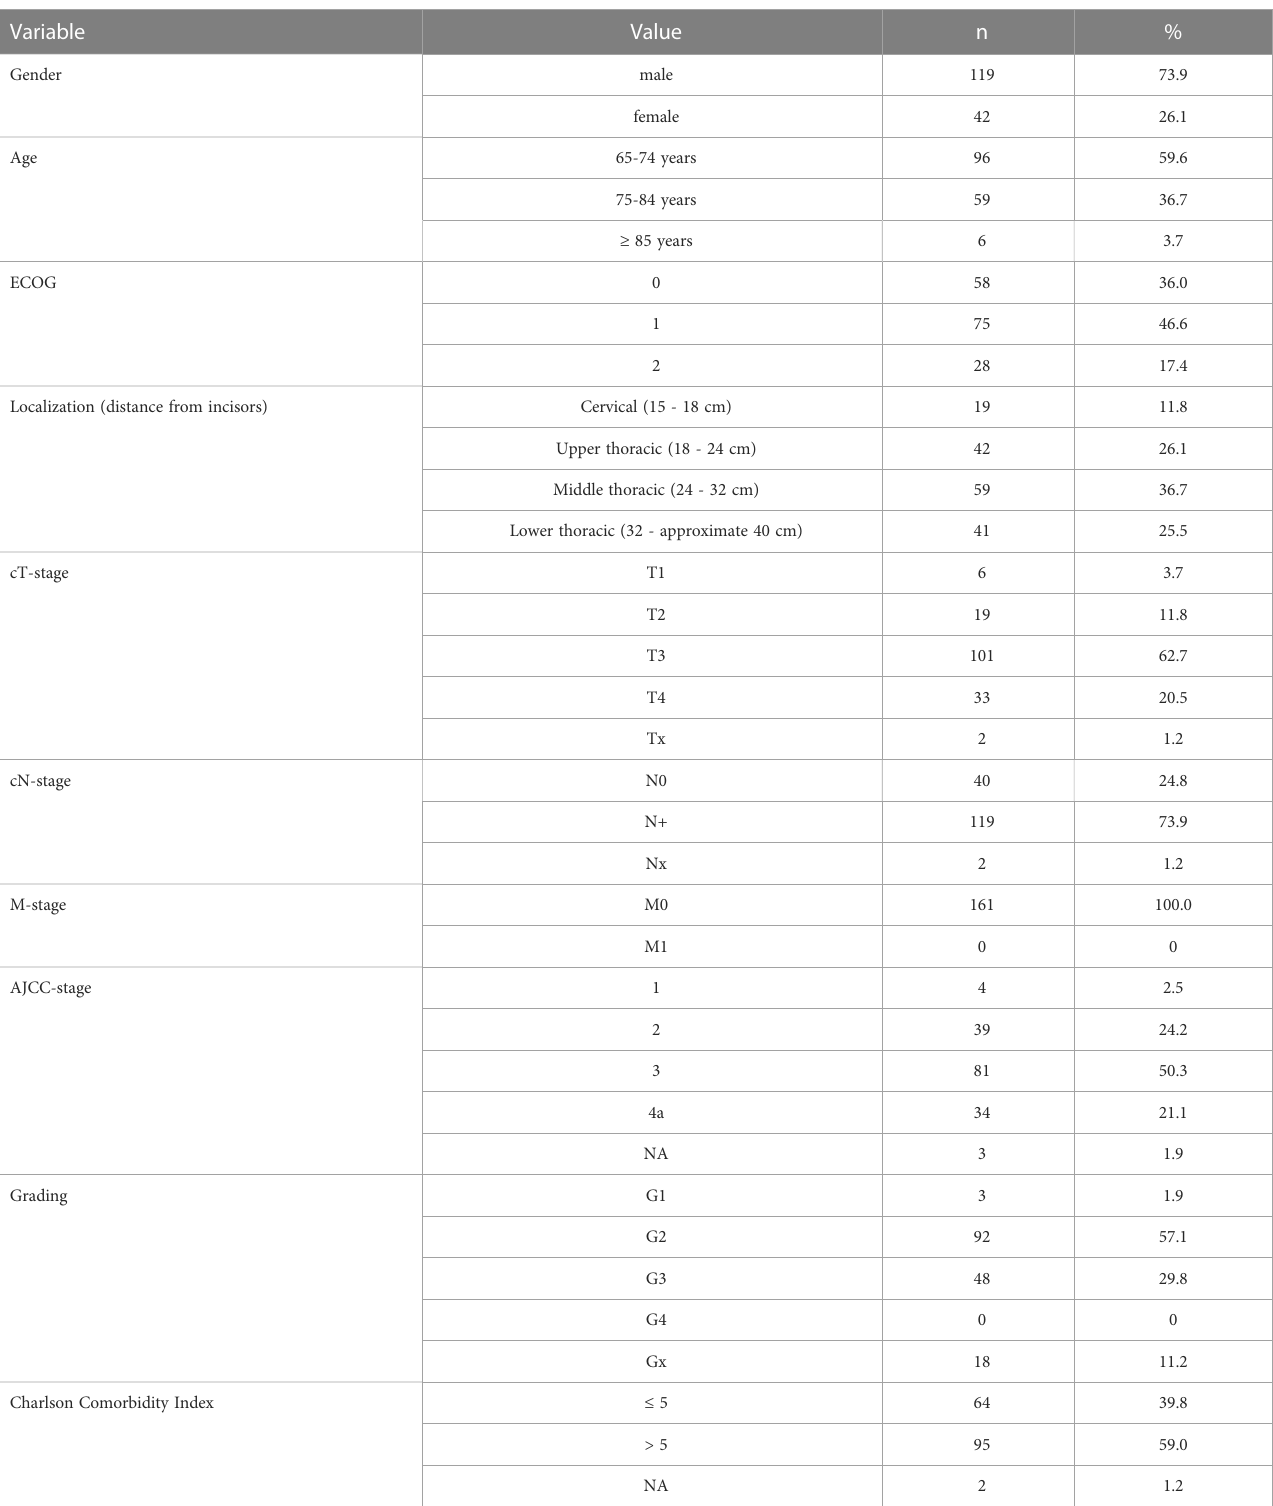
TABLE 1 Tumor and patient characteristics at